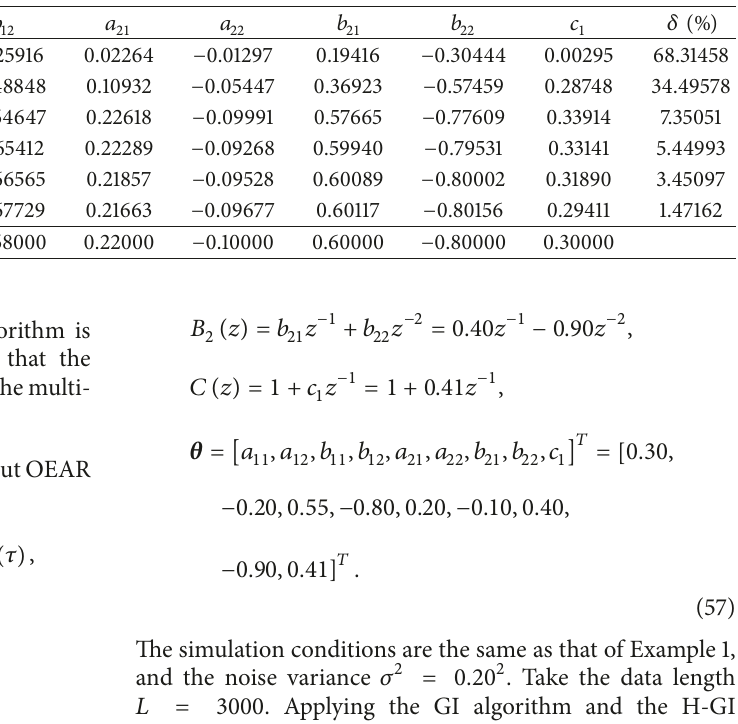
Table 5: The H-GI parameter estimates and errors for Example